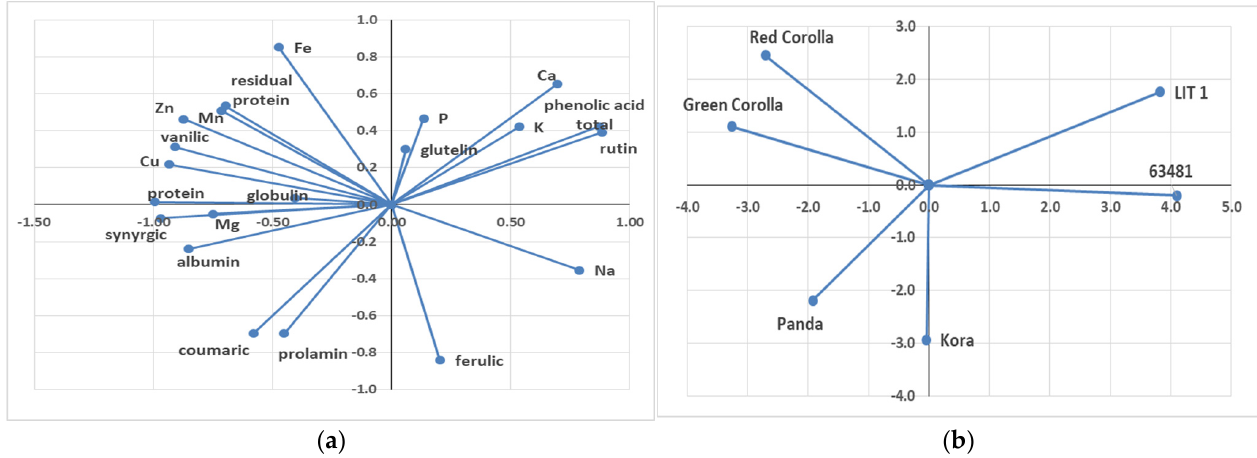
Figure 5. Principal component analysis (PCA) of tested parameters of F. esculentum and F. tataricum genotypes ( a ) and individual graph of the tested genotypes ( b ).